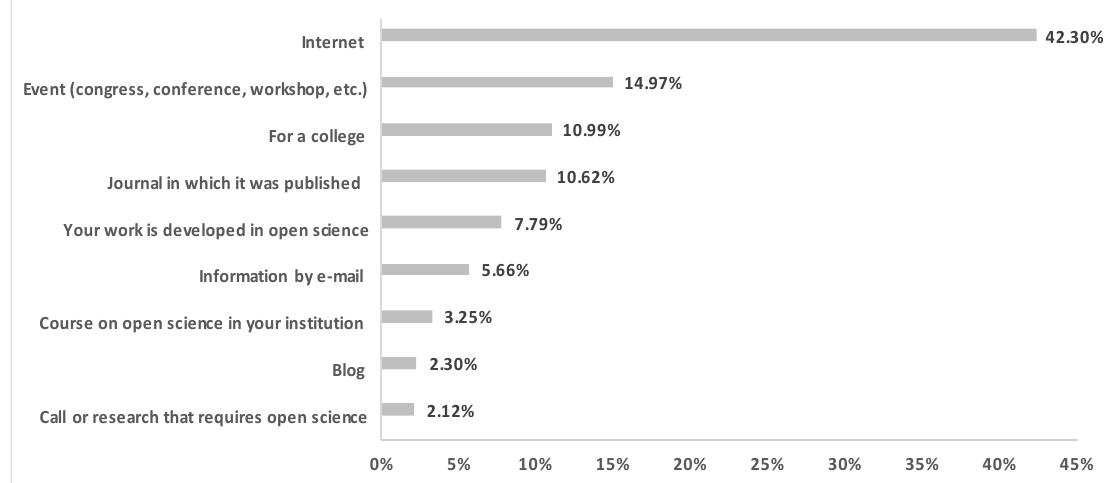
Figure 4. The main media platforms used by Colombian researchers to find information about open science.